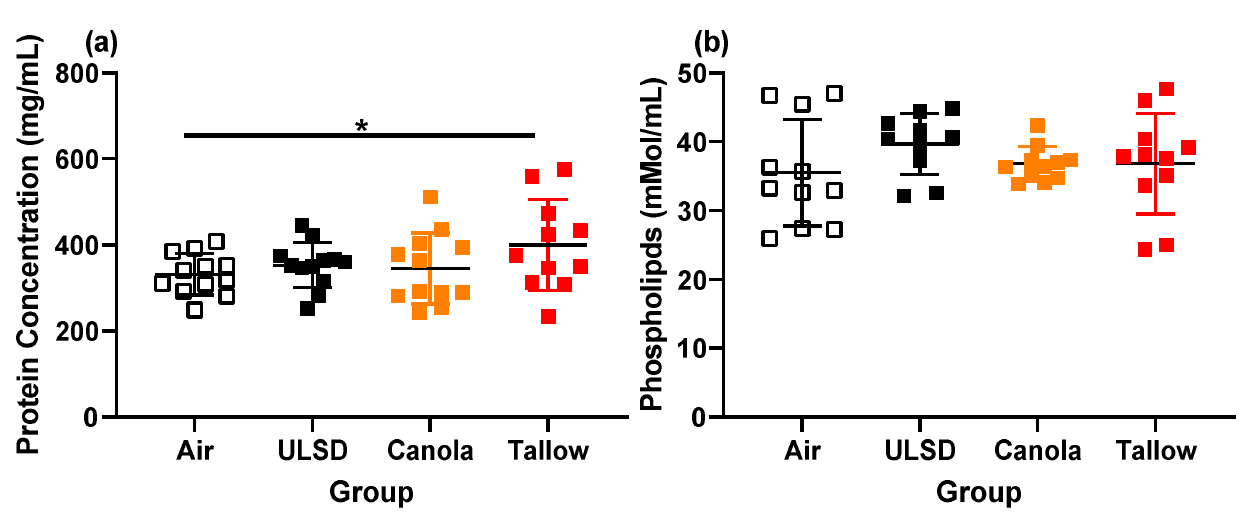
Figure 7. ( a ) Total protein concentration in the bronchoalveolar lavage and ( b ) total phospholipid concentration in the bronchoalveolar lavage for mice exposed to Air, ULSD, Canola, or Tallow biodiesel exhaust for 2 hr/day for 8 days. For protein, n = 12 except Tallow where n = 11. For phospholipid concentration, n = 11 except for ULSD where n = 10 (* = p < 0.05). Data were analyzed using general linear modeling methodologies. Data are individual mice with mean ± SD.